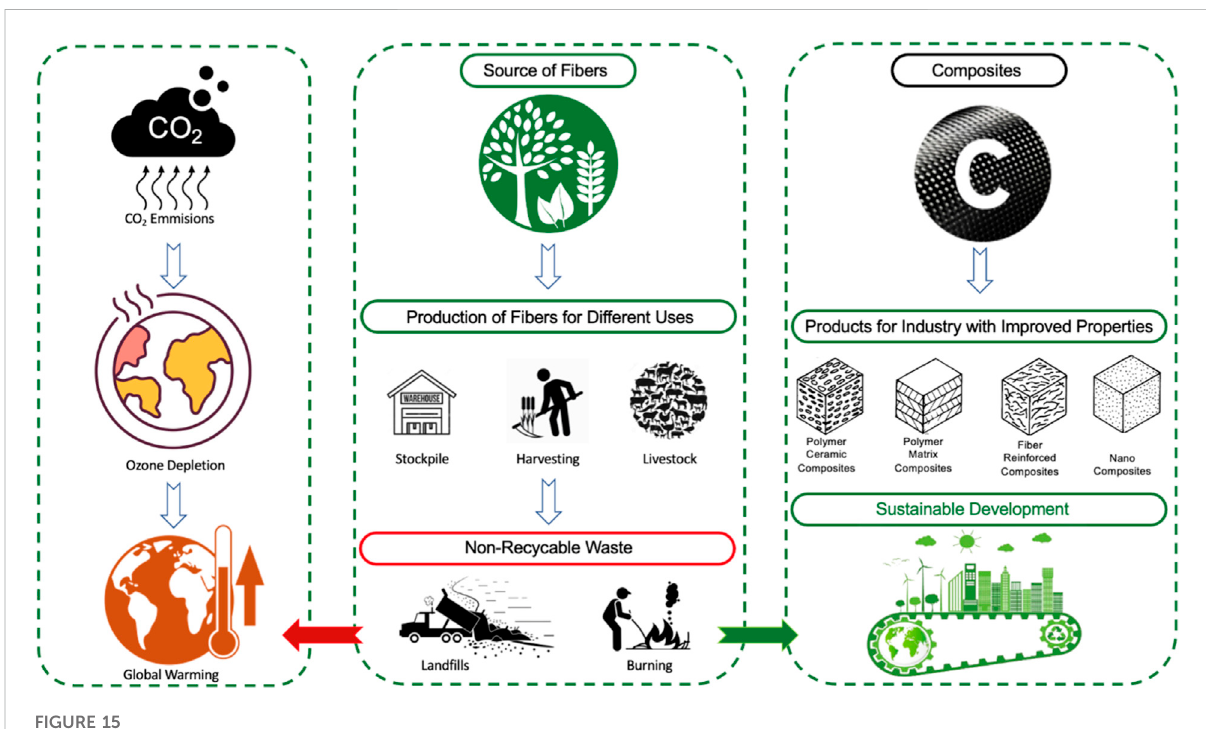
Concept of using mineral fi bers to achieve sustainable